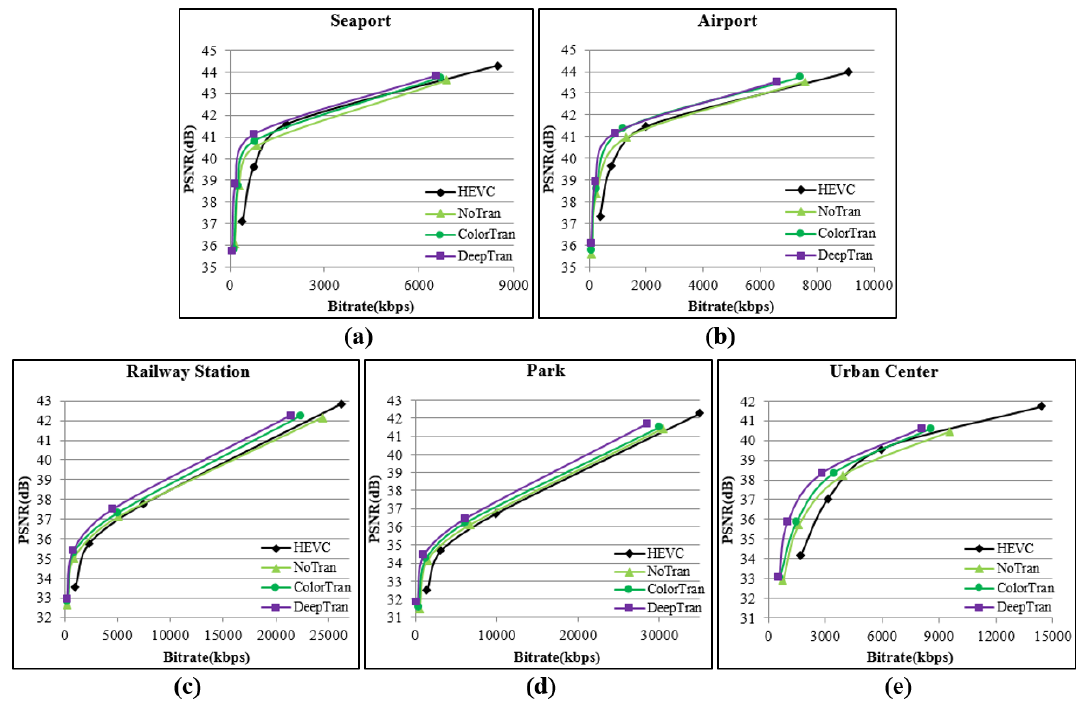
Figure 10. RD curves of five video clips from satellite data. ( a ) Seaport (Valencia); ( b ) Airport (Atlanta); ( c ) Railway Station (Munich); ( d ) Park (Madrid); ( e ) Urban Center